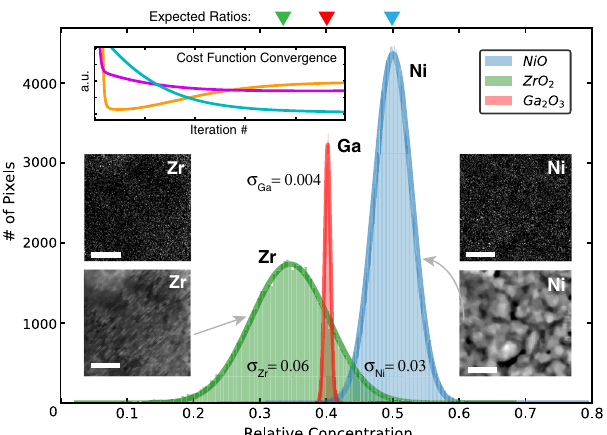
Fig. 5 Measuring relative concentration for experimental and synthetic datasets. Pixel intensity histograms for an experimental Zr (green), Ni (blue), and synthetic Ga (red) concentration maps. The standard deviation ( σ ) for each element is reported. The raw and reconstructed EDX maps are illustrated inside of the plot. Ground truth concentrations are highlighted by the respective colored triangles above the top axis. Stable convergence for the three components in the cost function: model term (orange), data fi delity (magenta), and regularization (turquoise) are illustrated in the inset. Qualitatively the convergence is identical for all three example datasets. Zr and Ni scale bars: 5, 10 nm, respectively.